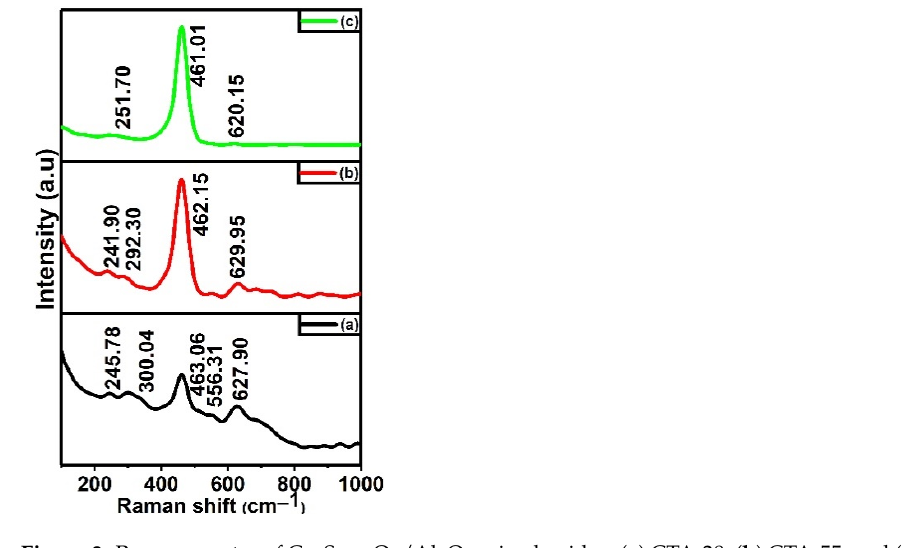
Figure 3. Raman spectra of Ce x Sn 1-x O 2 /Al 2 O 3 mixed oxides. ( a ) CTA-28, ( b ) CTA-55, and ( c ) CTA-82.